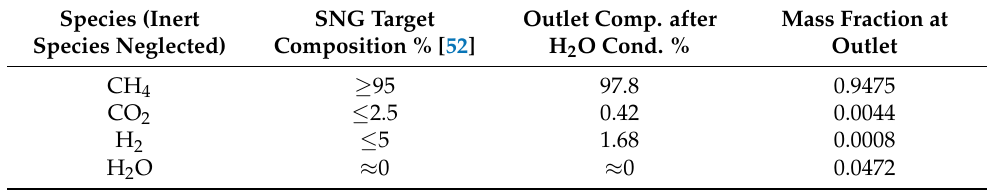
Figure 15. Axial temperature profile at representative tube centerline (0.5-m reactor module) under 7-m 3 /h thermal oil feed rate. 7-m 3 /h thermal oil feed rate. Table 7. Outlet gas composition and SNG quality requirements (0.5 m reactor